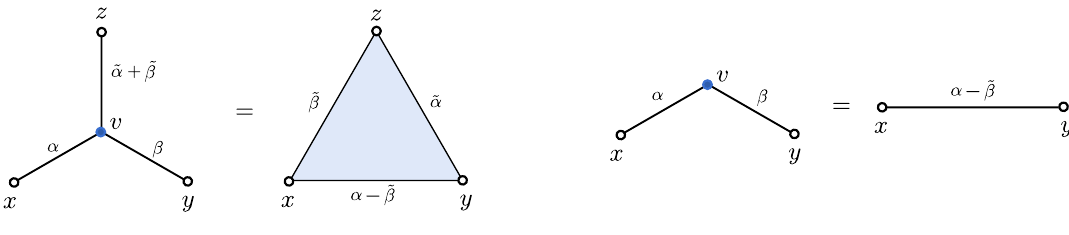
− x . Right: chain- 2